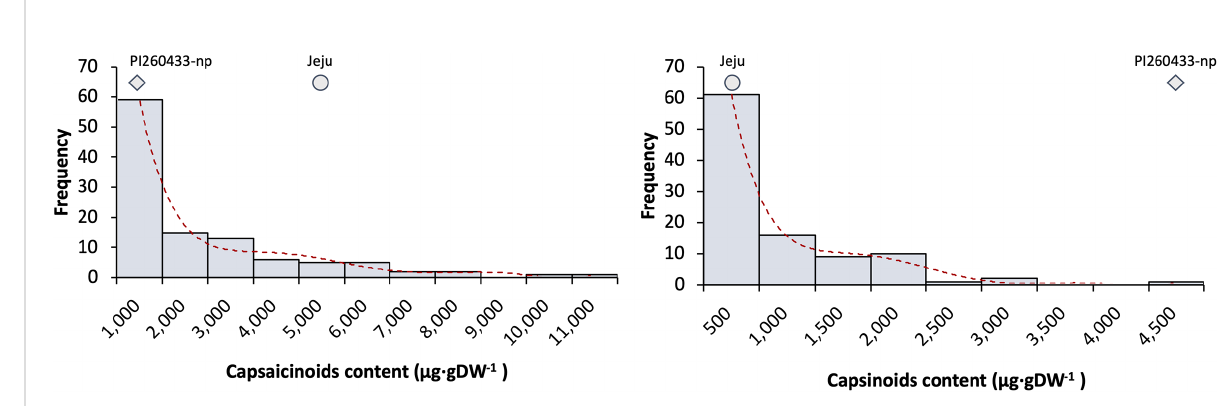
FIGURE 1 Frequency distribution of capsaicinoid and capsinoid contents in the ‘ PJ ’ F2 population. The x-axis indicates the number of plants (frequency), and the y-axis indicates the range of capsaicinoid (left) or capsinoid (right)